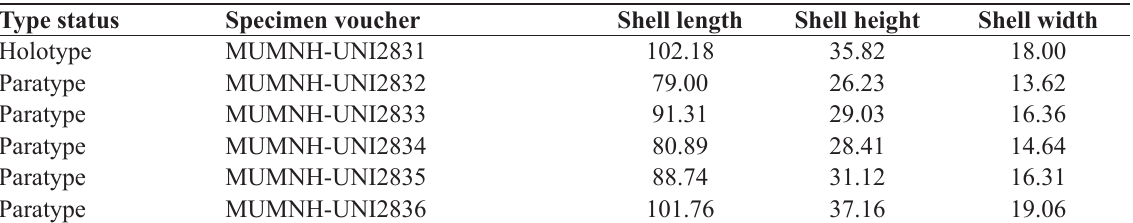
Table 3. Shell measurements for the type series of Namkongnaia inkhavilayi gen. et sp. nov. Measurements in millimetres